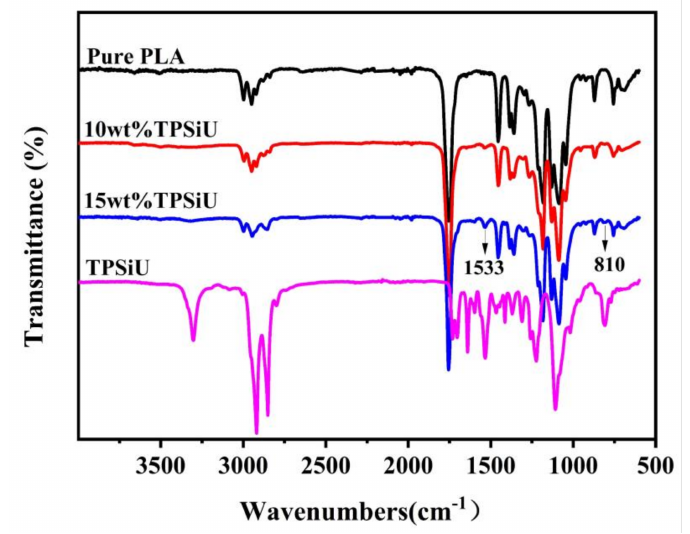
Figure 2. Fourier transform infrared (FTIR) spectra for polylactic acid (PLA), PLA/10 wt% thermo- plastic silicone polyurethane elastomer (TPSiU), PLA/15 wt% TPSiU and TPSiU.